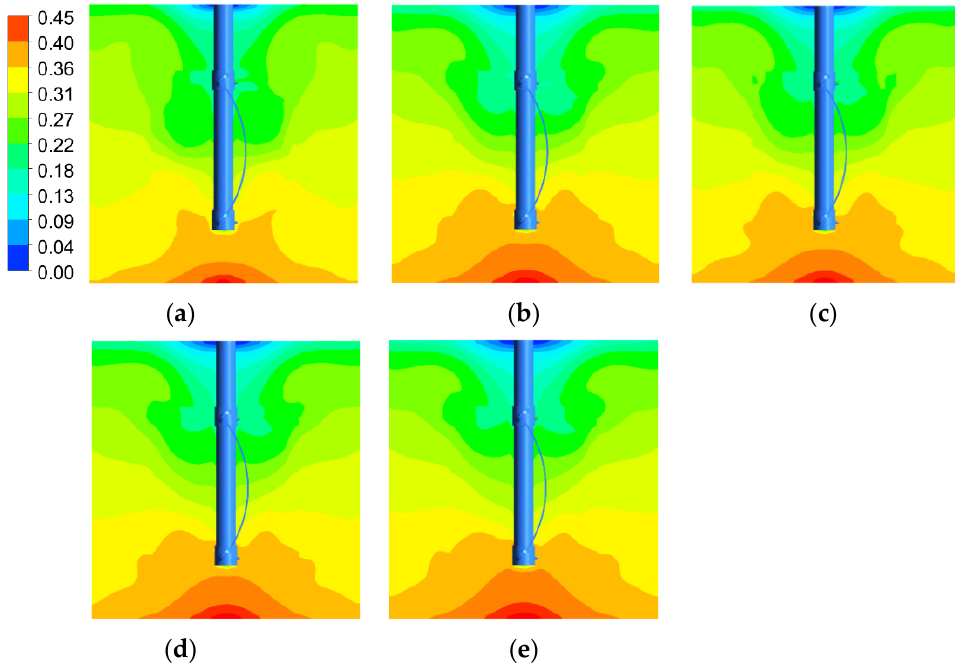
Figure 20. Contour plots of solid distribution for DRFTBI with different connection strap width. ( a ) D/5; ( b ) D/6; ( c ) D/7; ( d ) D/8; and ( e ) D/9. (Rotational speed: 120 rpm; solid loading: 30%; connection strap length: 1.2